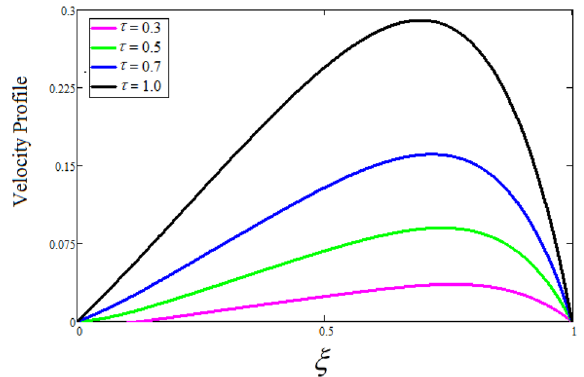
Figure 12. The consequence of t on velocity distribution. Where R ζ = 2, φ = 0.04, δ = γ = π 3 , M = 5, k = 0.3, Gr = 10, Gm = 20, β = 0.2, α = 0.5, Sc = 10,